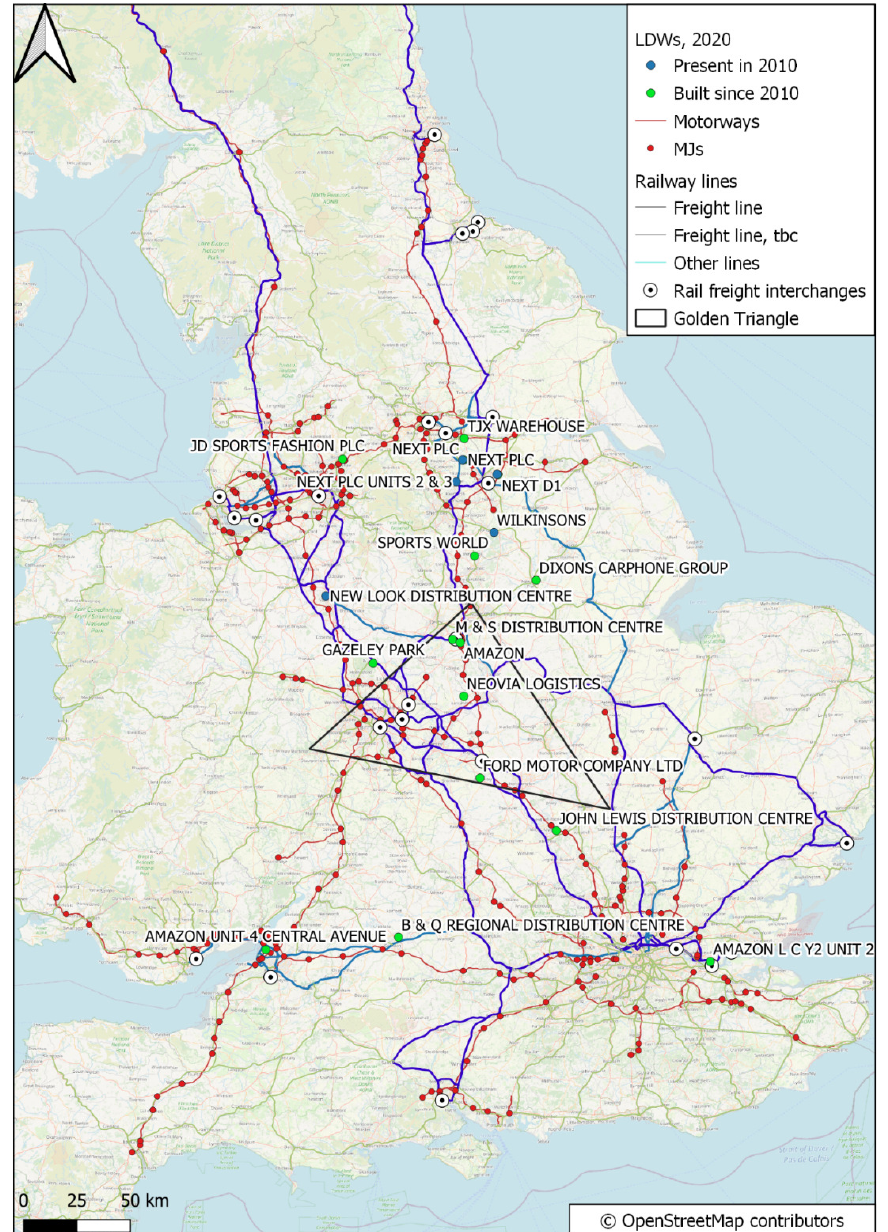
Figure 2. Location of the 20 largest LDWs,